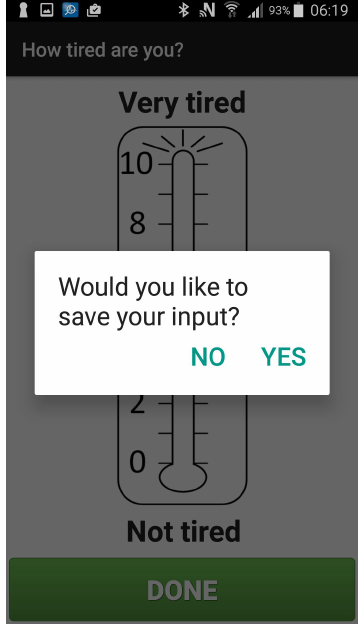
Figure 3. Confirmation